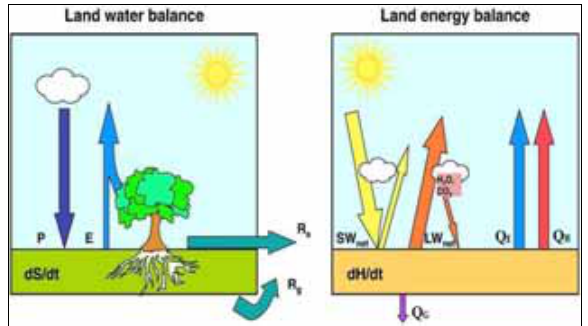
Figure 3. Schematic diagram of the land water balance (left) and land energy balance (right) for a given surface soil layer.